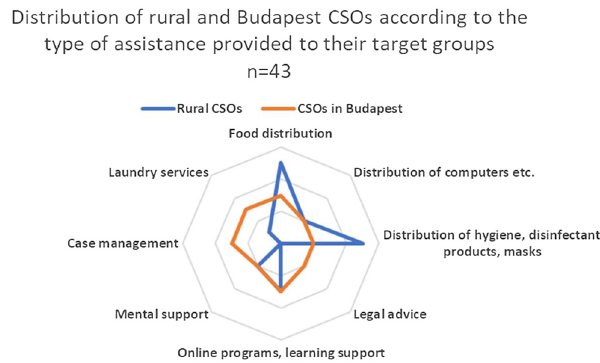
Figure 8: Distribution of organizations in Budapest and rural areas according to the assistance they provided to their target